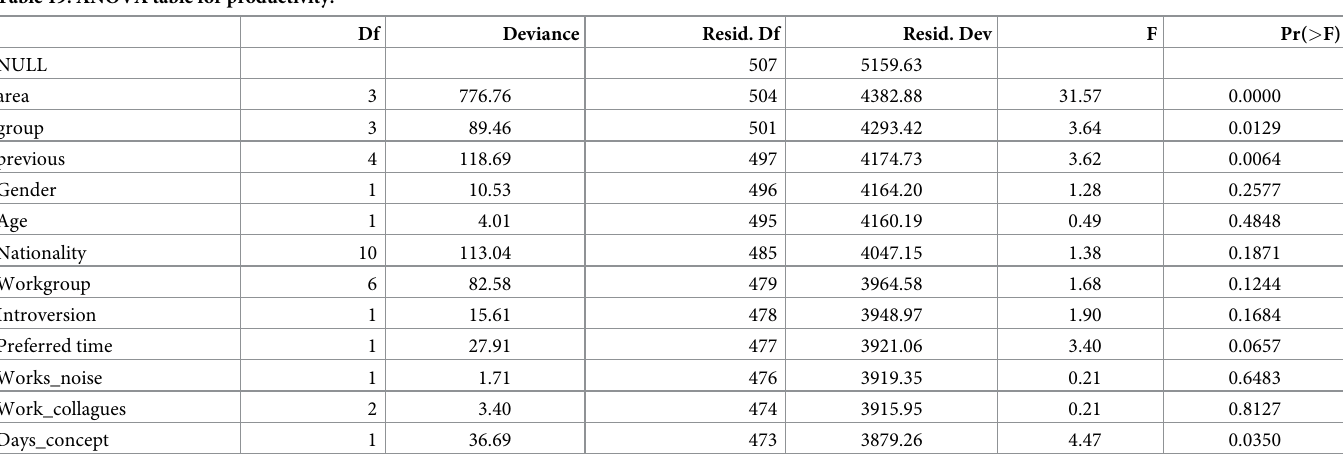
Table 19. ANOVA table for